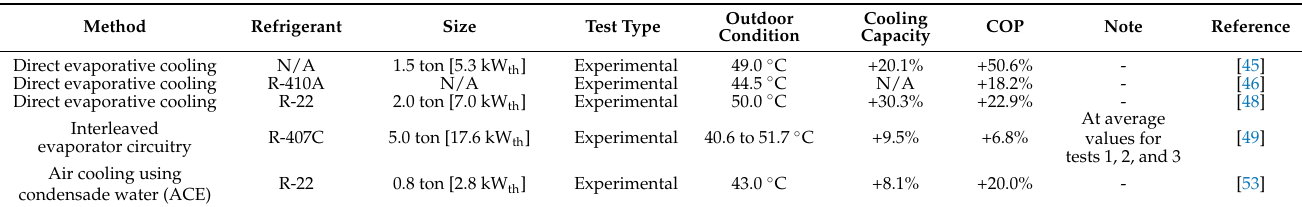
Figure 6. Improvements of different technologies applied to either evaporator or condenser [45,46,48,49,53]. Table 7. Details of condenser or evaporator improvements for each method.